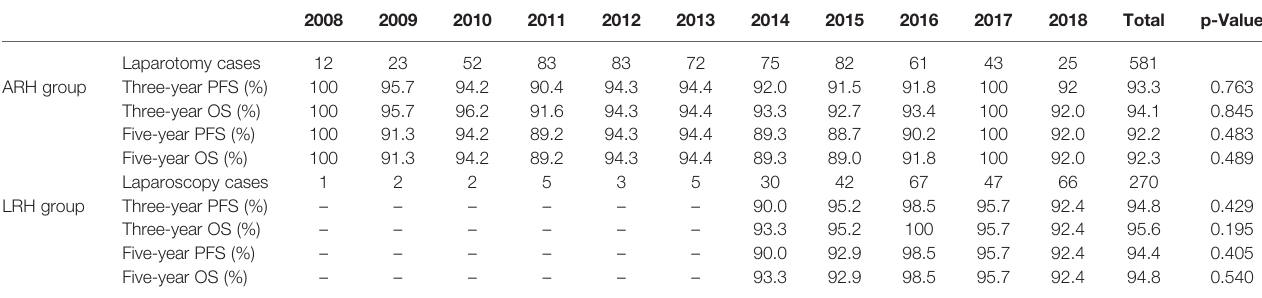
TABLE 3 | Survival outcomes of different years in ARH and LRH groups.